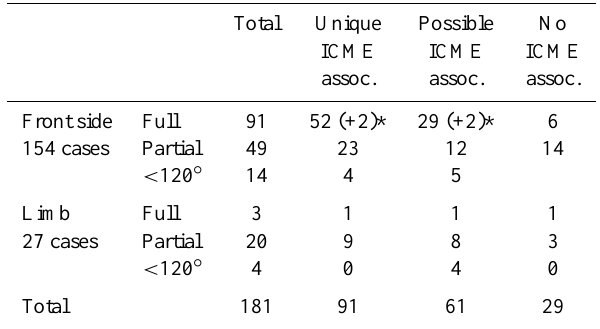
Table 2. Association of CME events (back side events excluded) with ICME observations at 1 AU. Total Unique Possible No ICME ICME ICME assoc. assoc.